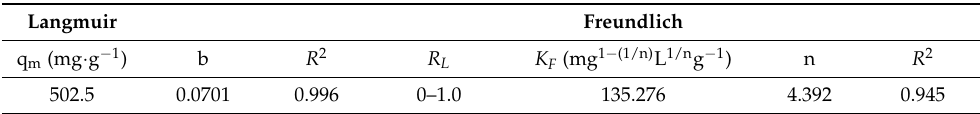
Table 1. Adsorption isotherm parameters for CR adsorption on magnetic PGMA-g-PPy by the Langmuir and Freundlich models.